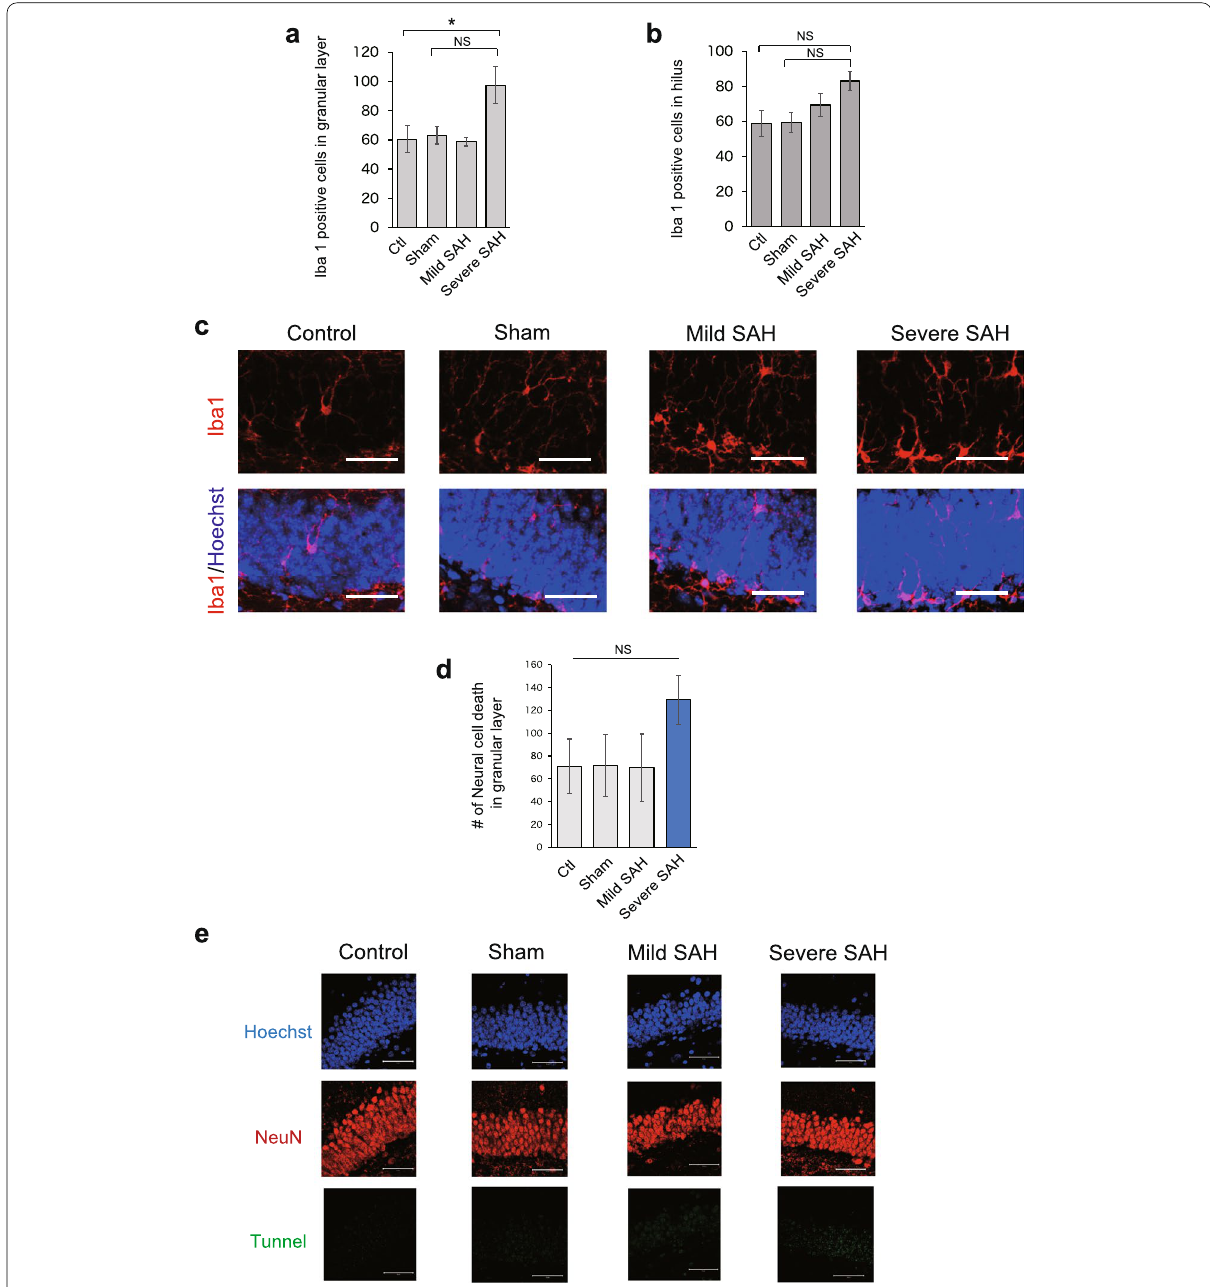
Fig. 11 Neuroinflammation and neural cell death in the hippocampus. a Quantification of the number of Iba1-positive cells in the granular layer ( n 4, each group, control vs. severe SAH; p 0.043, sham vs. severe SAH; p 0.062). b Quantification of the number of Iba1-positive cells in the hilus = = = ( n 4, each group, control vs. severe SAH; p 0.085, sham vs. severe SAH; p 0.097). c Representative immunostaining images of Iba1-positive = = = cells (red) in the hippocampi of mice in the control, sham, mild SAH, and severe SAH groups. Scale bar, 100 μm. d Quantification of the number of dead neural cells in the granular layer ( n 3, each group. e Representative confocal images of TUNEL (green) and NeuN (red) in the hippocampus. = Scale bar, 100 μm. Statistical analyses were performed with one-way ANOVA and Tukey–Kramer post hoc tests. The values in the bar graphs represent the mean SE. NS: not ±